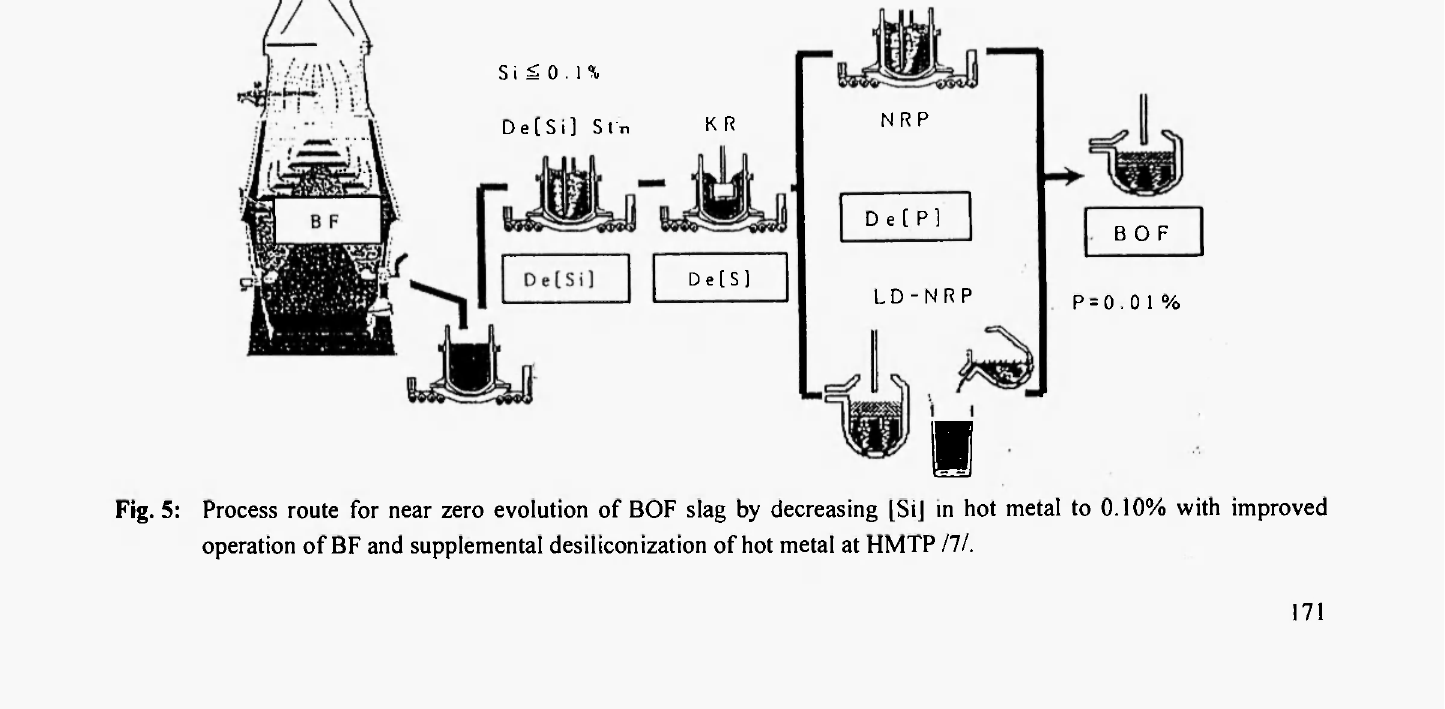
Fig. 5: Process route for near zero evolution of BOF slag by decreasing ISiJ in hot metal to 0.10% with improved operation of BF and supplemental desiliconization of hot metal at HMTP